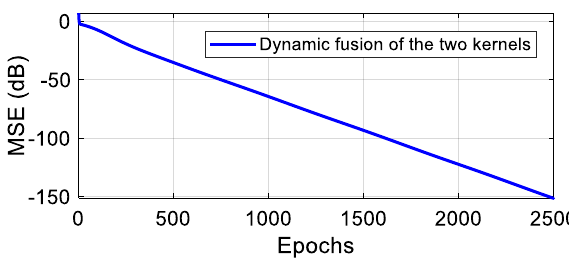
Figure 7. Mean square error curve of the training phase of the dynamic fusion of kernels.